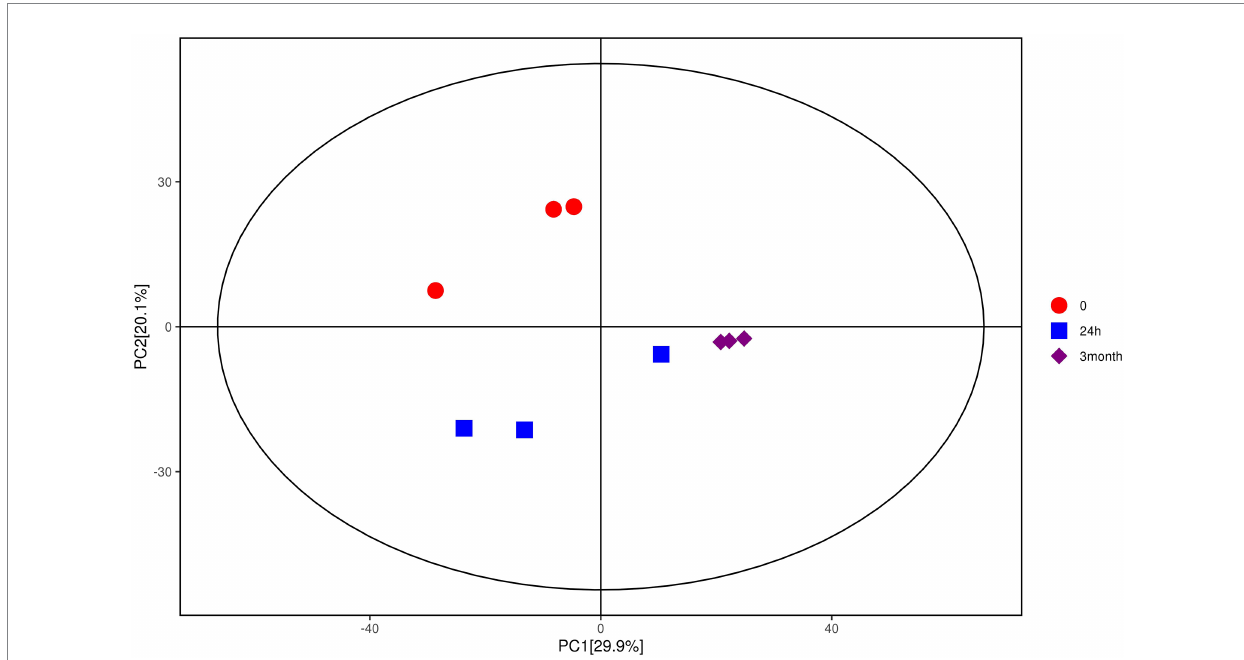
FIGURE 1 Score scatter plot for PCA model of metabolites of Salmonella after desiccation treatment and SMP storage. The x -axis PC1 and y -axis PC2 represents the aggregation of the first and second principal components, respectively. The color and shape of the scatters represent the experimental grouping of the samples. The samples are all within the 95% confidence interval (Hotelling’s t -squared